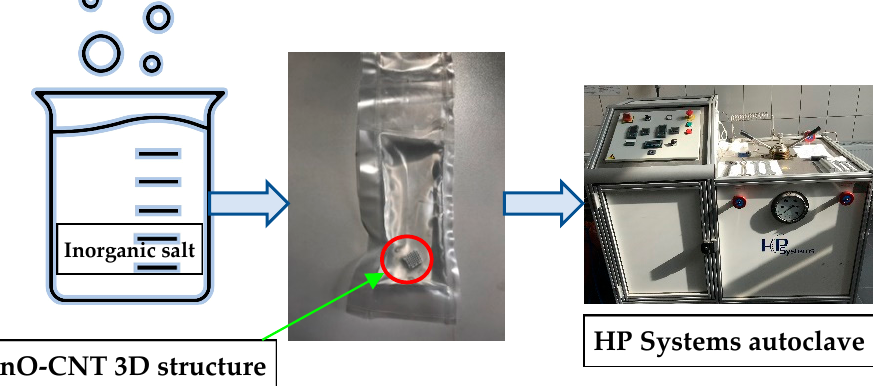
Figure 1. Impregnation of ZnO-CNT composite 3D structures with inorganic salts in isostatic pressure conditions.